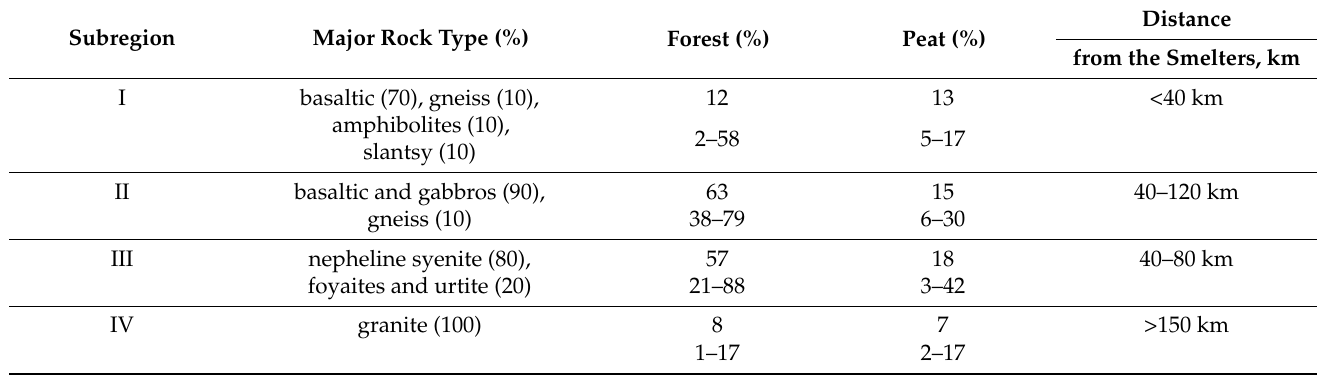
Figure 2. Emissions of SO 2 (thousand tons per year), Cu and Ni (tons per year) Ni–Cu smelter in Kola North [34]. Table 1. Landscape (forest, peat) and geochemical characteristics (major rock type) of the identified subregions of the Kola